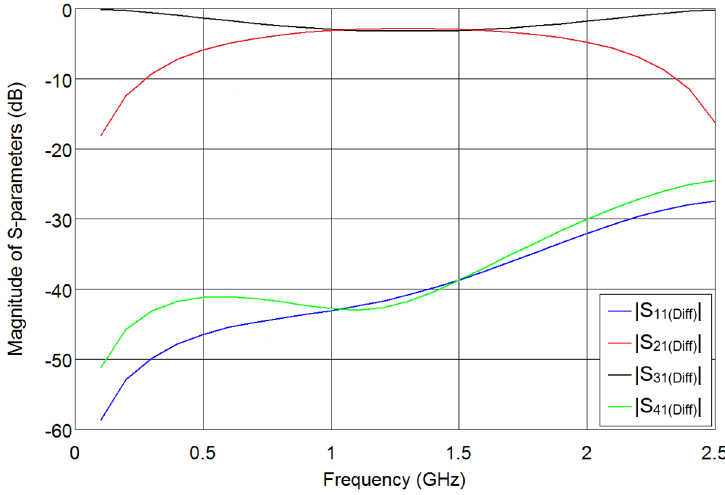
Figure 5. Electromagnetically calculated differential S ‐ parameters of the compensated differential coupled ‐ line directional coupler.